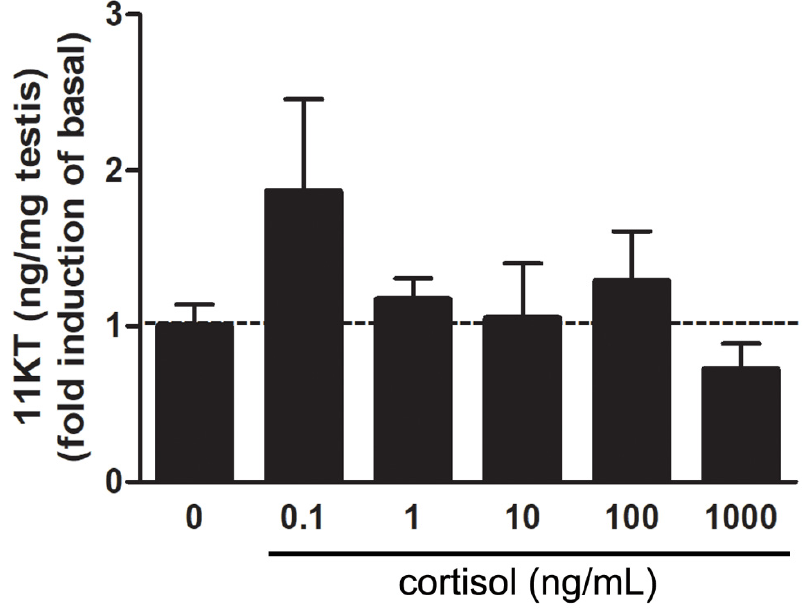
Figure 1. Androgen release from zebrafish testicular explants. Amounts of 11-KT (11-Ketotestosterone) (ng / mg of testis weight) measured in the incubation media after short-term exposure (18 h) to increasing concentrations of cortisol (0, 0.1, 1, 10, 100, and 1000 ng / mL). Data are expressed as mean ± SEM fold change ( n = 8 per concentration), relative to the control condition, which is set at 1 (dashed line).